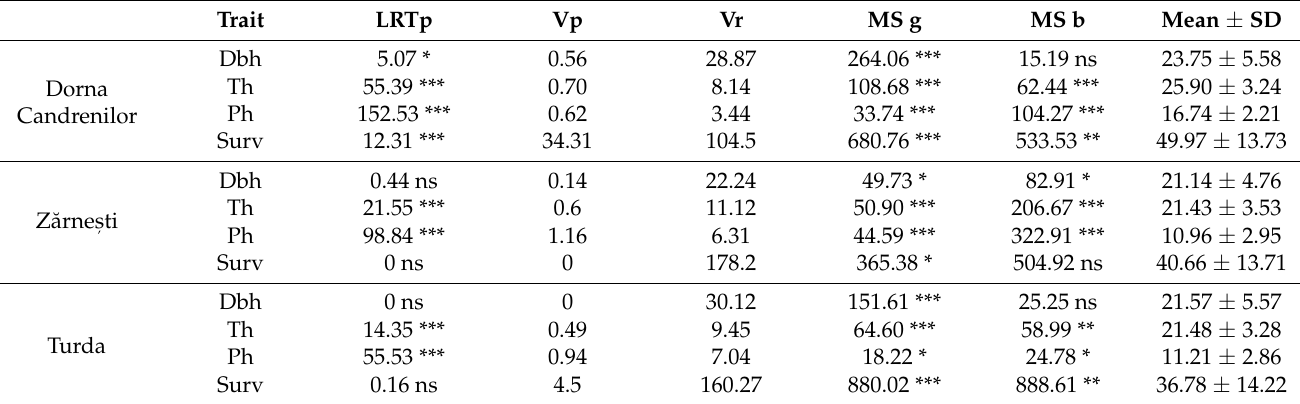
Table 1. The results for random- and fixed-effects of the four traits in each Norway spruce provenance trials evaluated at age 49.